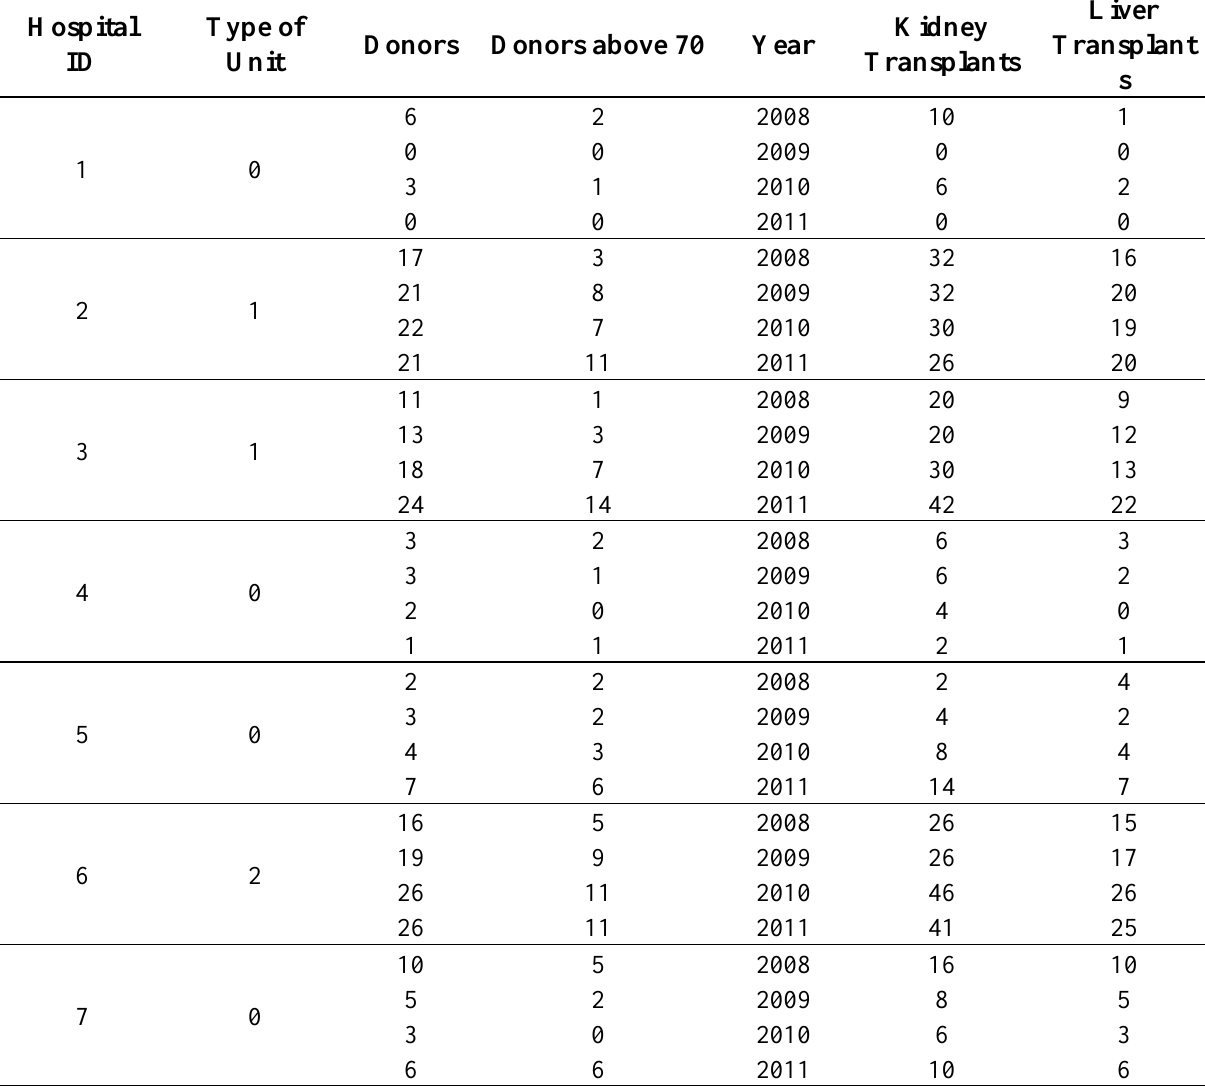
Table A1. Panel data corresponding to 11 hospitals involved in the Spanish system for organ donation and transplant for the period (2008–2010)